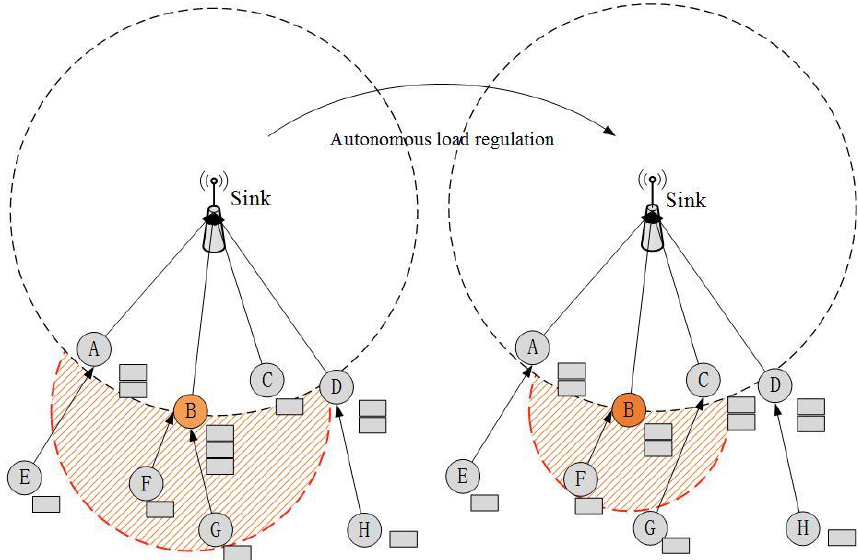
Figure 2. Operation principle of the routing strategy.